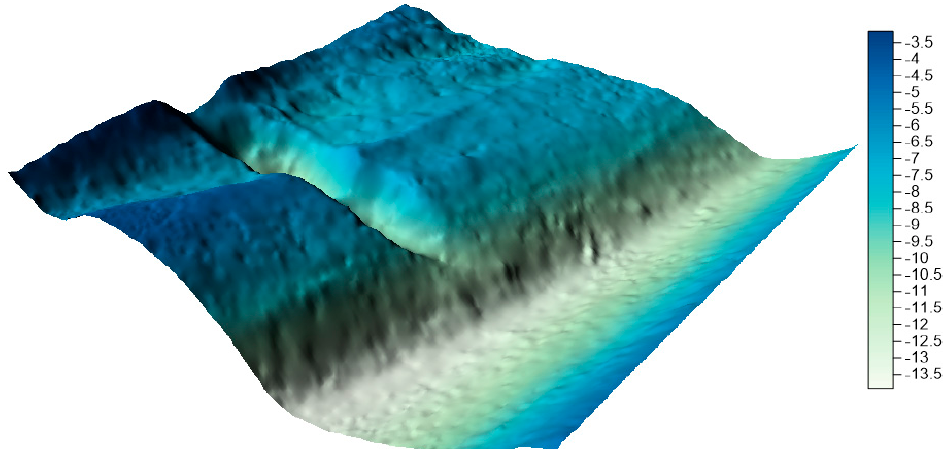
Figure 16. Surface obtained by integrated dataset no. 2 for the Inski canal area.